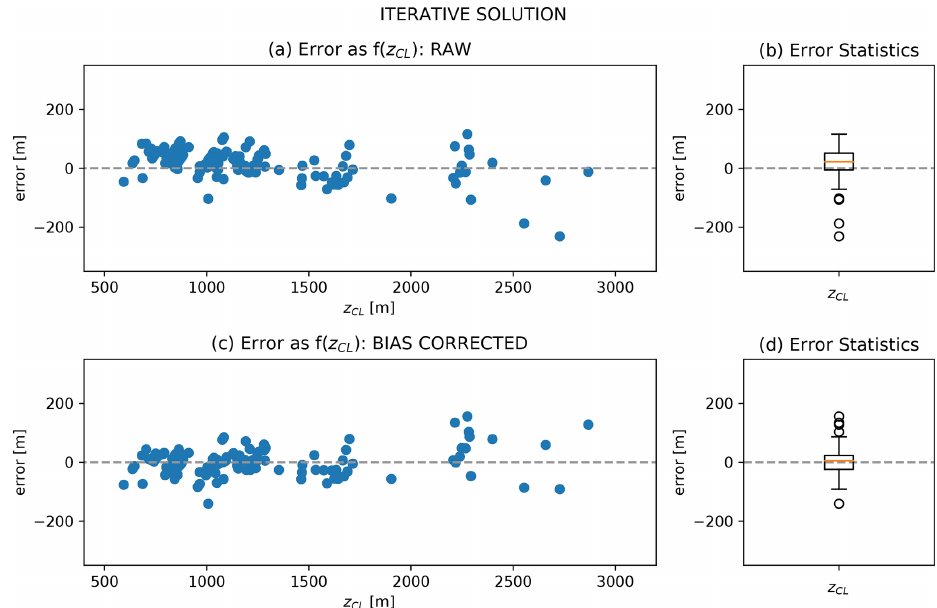
Figure 5. Performance of the smoke injection height parameterization based on the iterative solution (Eq. 8). (a) Non-bias-corrected model prediction error (true – modelled z CL ) as a function of z CL . (b) Error statistics for the non-bias-corrected model. The box and whiskers span the interquartile range (IQR) and 1 . 5 × IQR, respectively. Median value is shown in orange. (c) Bias-corrected model prediction error as a function of z CL . (d) Error statistics for bias-corrected model.